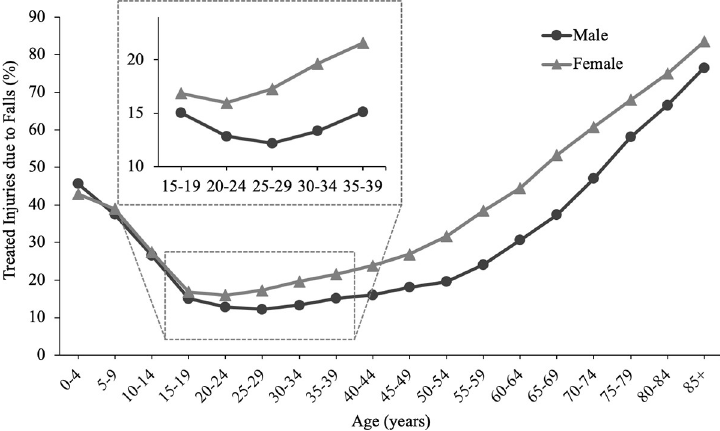
Fig 1. Percent of all medically treated injuries that resulted from falls as a function of age and sex for 2015. Data extracted from the CDC’s Web-based Injury Statistics Query and Reporting System (WISQARS TM ) for non-fatal injuries [7]. Inset shows greater detail for ages 15–39